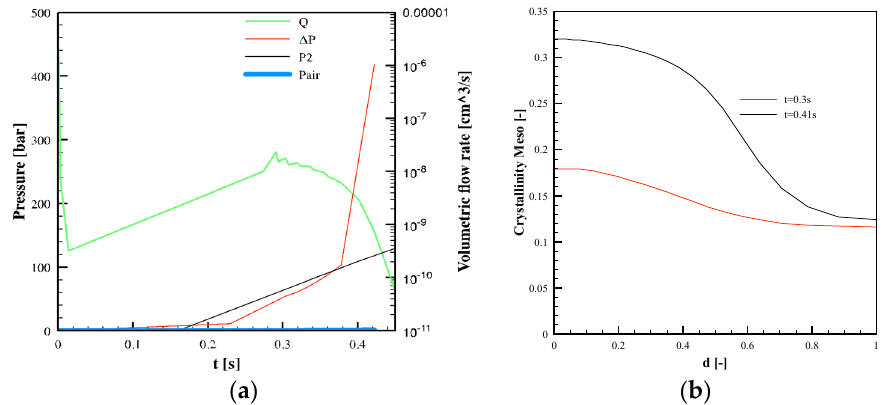
Figure 13. Evolution of pressures and volumetric flow rate in the microstructure corner ( a ) and overall crystallinity distributions along the dimensionless distance from the corner surface, d, in position L1 ( b ). In both plots are shown variables calculated for the Passive condition by adopting Vincent’s viscosity modification.